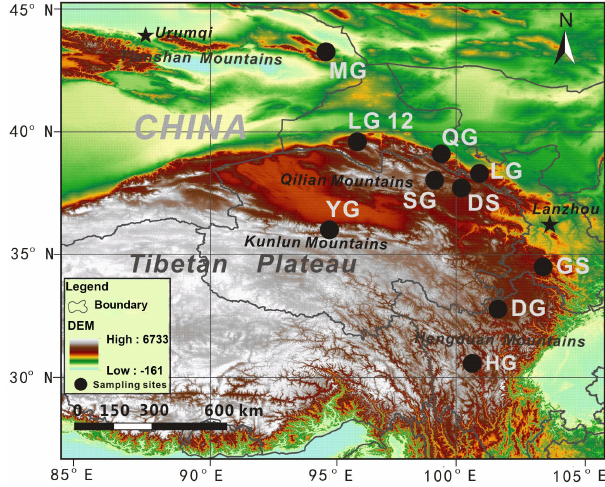
Figure 1. Location map showing the sampled glaciers and snow- pack in the northeastern Tibetan Plateau, including the Miaoergou Glacier (MG), Laohugou Glacier no. 12 (LG12), Qiyi Glacier (QG), Lenglongling Glacier (LG), Shiyi Glacier (SG), Dabanshan snow- pack (DS), Yuzhufeng Glacier (YG), Gannan Snowpack (GS), Dagu Glacier (DG), and Hailuogou Glacier (HG), where large-range field observations of atmosphere and glacier surface impurities were con-